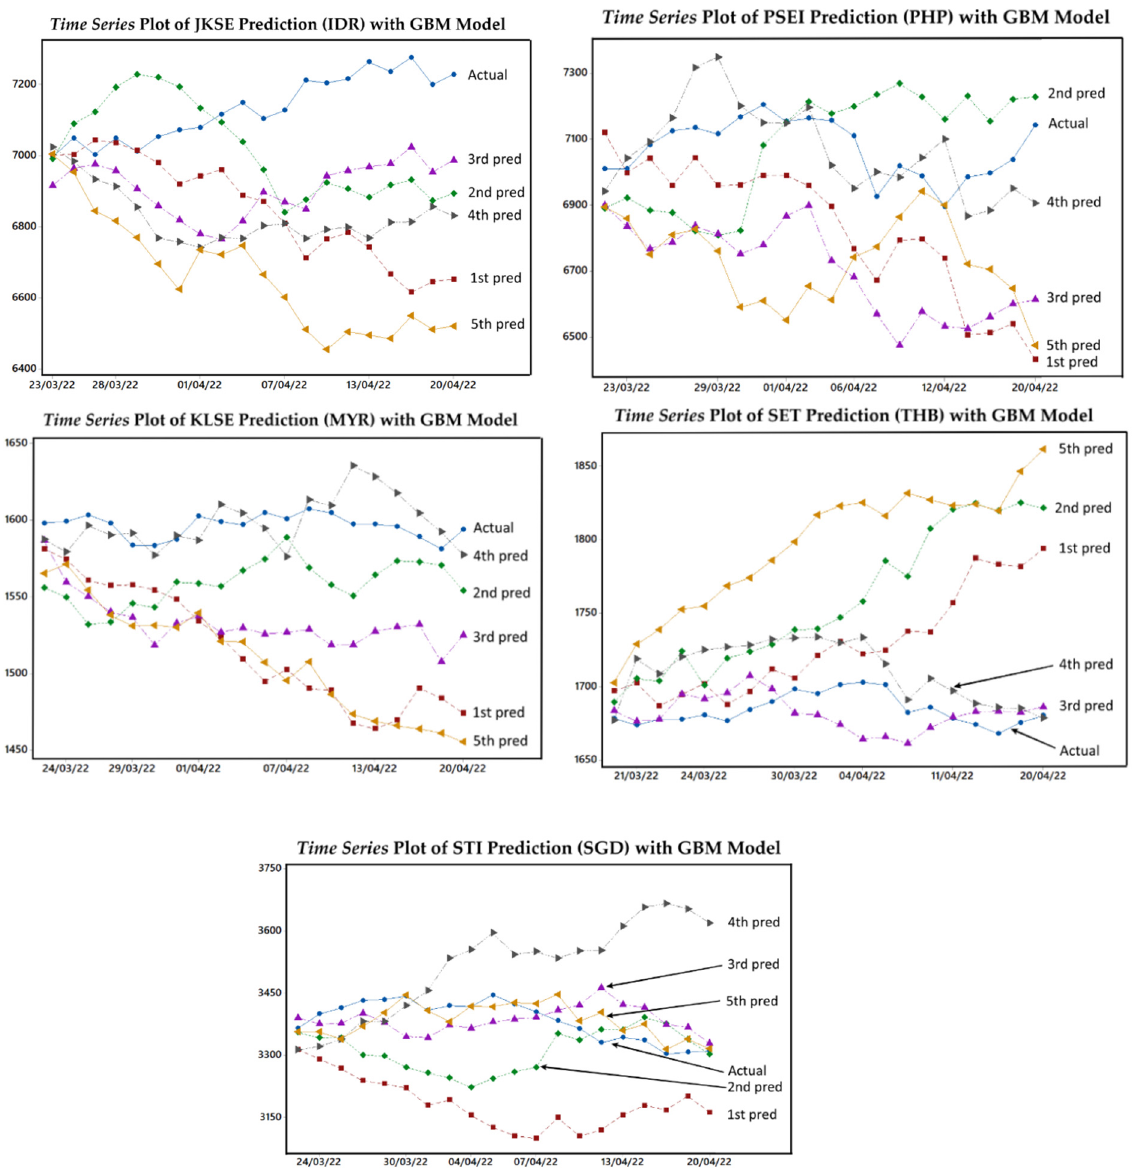
Figure 2. ASEAN top 5 stock price index predictions for next 20 periods with GBM model.